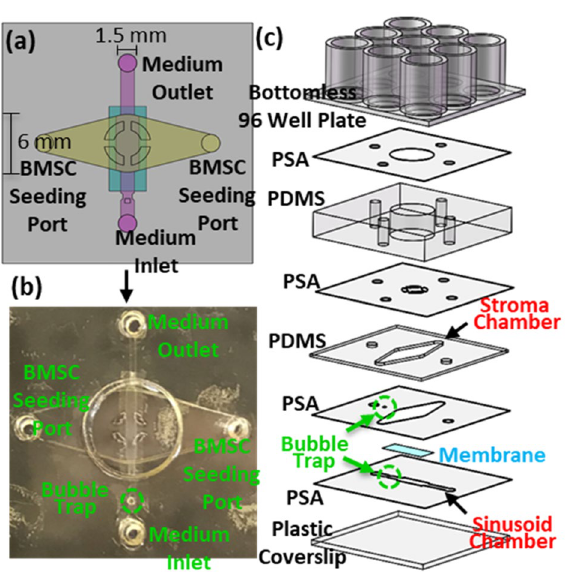
Figure 2. Design features of the sinusoid and stroma chambers. ( a ) and ( b ) Cross-sectional views of the device. ( c ) Top view of the device. ( d ) Simulated shear stress contours along the axial direction of the sinusoid chamber. ( e ) Bubble trap via chamber narrowing and storage along the sinusoid chamber.